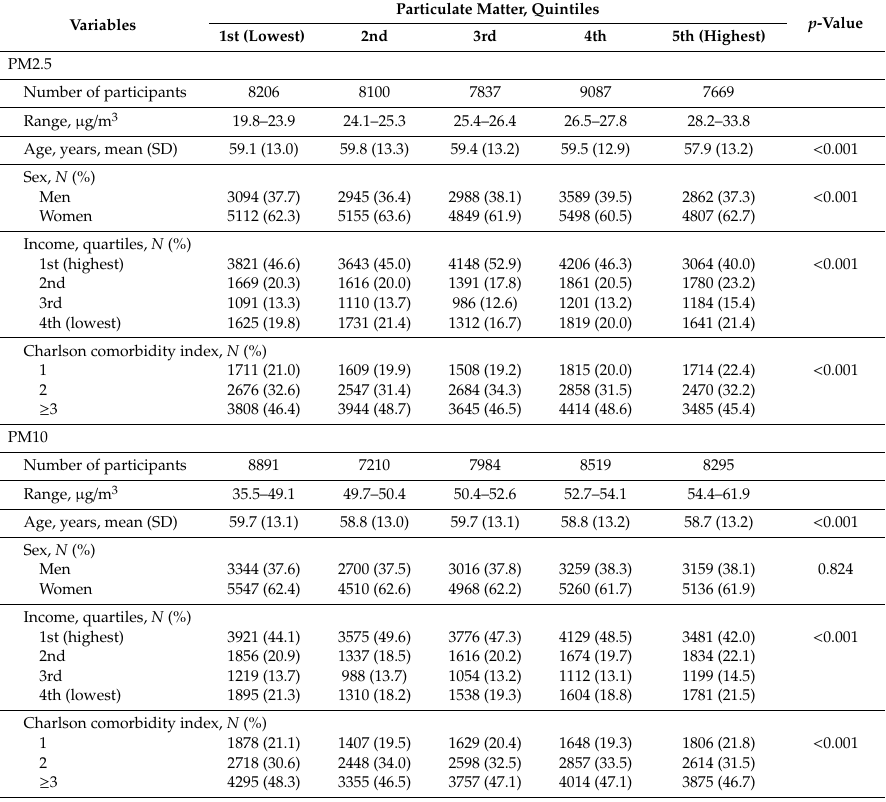
Table 1. Descriptive characteristics of the study